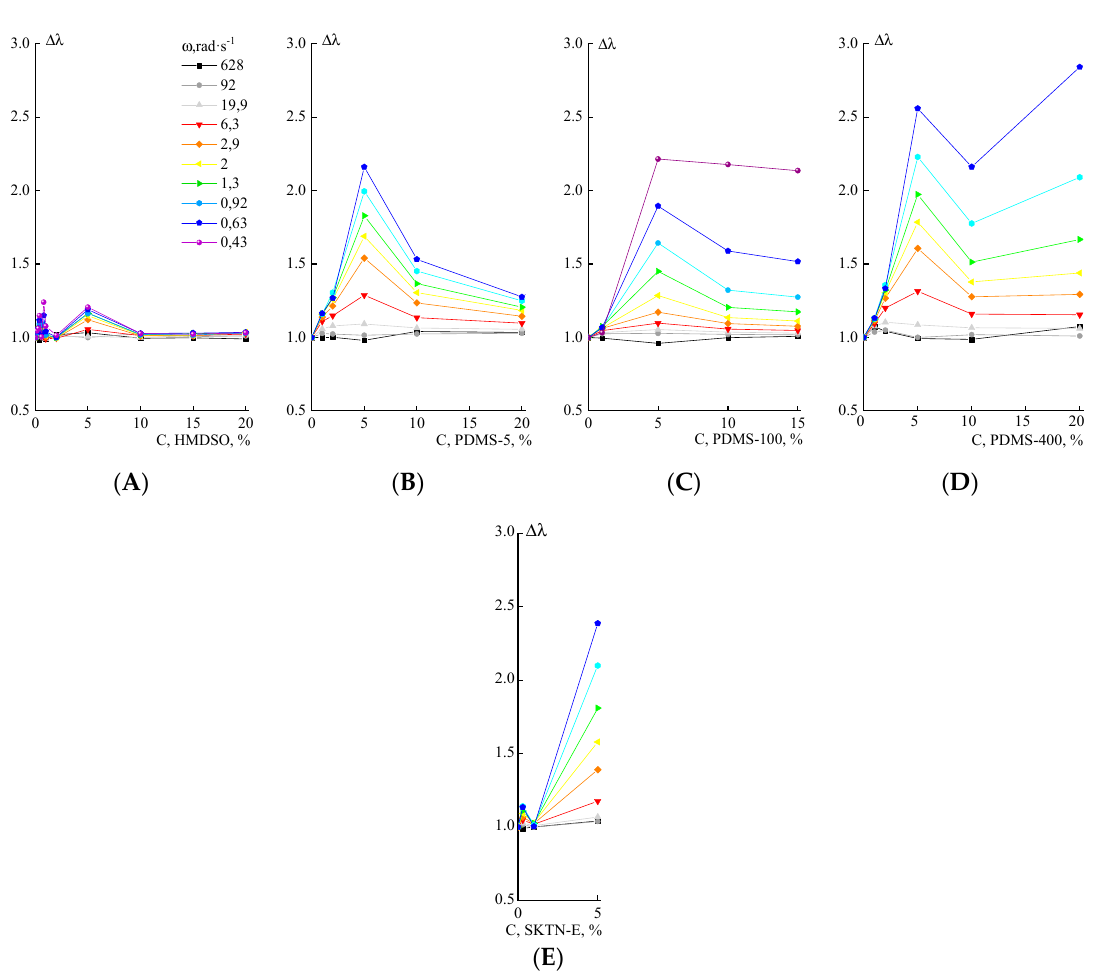
Figure 11. The dependence of the specific relaxation time at different frequencies on the concentration of polysiloxanes in the PAN solution: ( A )—HMDSO, ( B )—PDMS-5, ( C )—PDMS-100, ( D )—PDMS-400, and ( E )—SKTN-E.